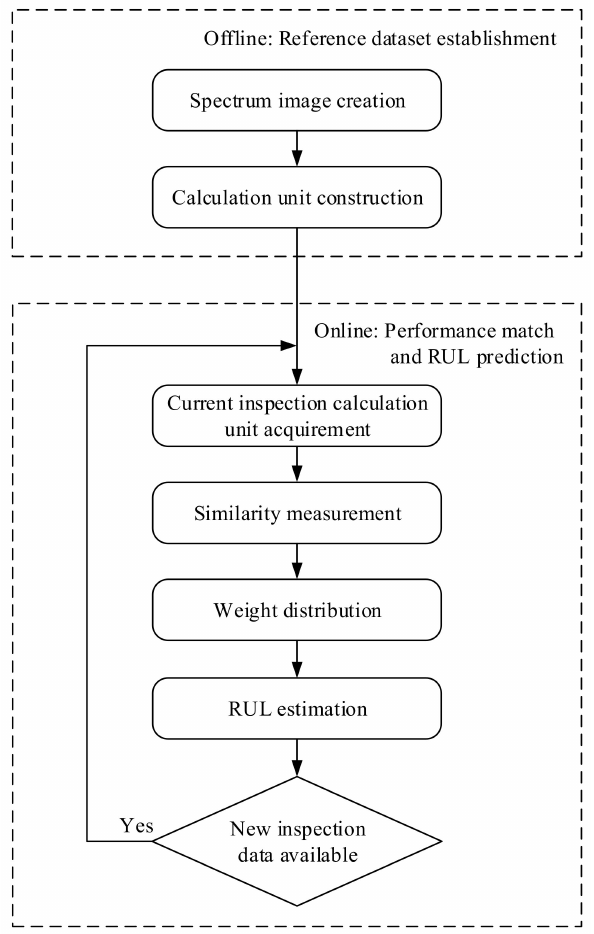
Figure 1. The flowchart of the proposed